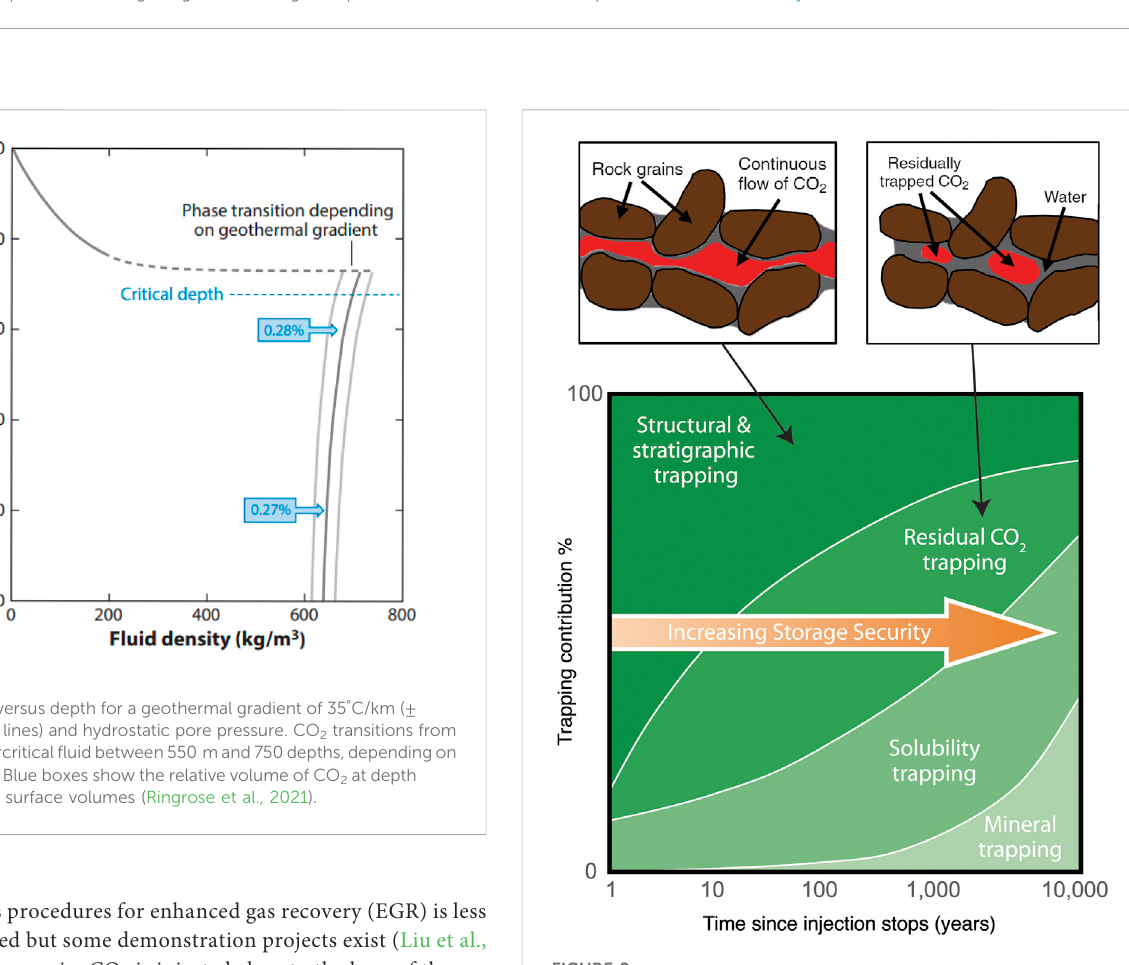
FIGURE 8 Conceptual representation of how the contribution of CO 2 trapping mechanisms change with time when CO 2 is injected as a supercritical fl uid (Modi fi ed after IPCC, 2005; Garcia et al., 2010; Snæbjörnsdóttir et al.,